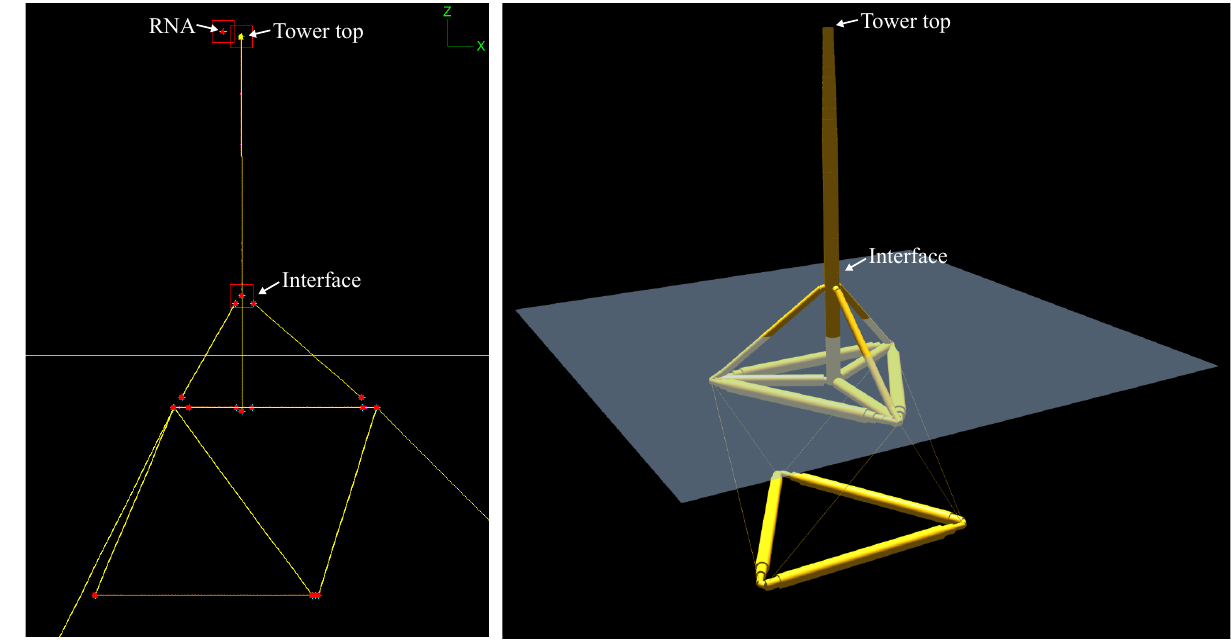
Figure 2. OrcaFlex ( left ) and OpenFAST ( right ) models of the TetraSpar FOWT foundation with definition of data sensor